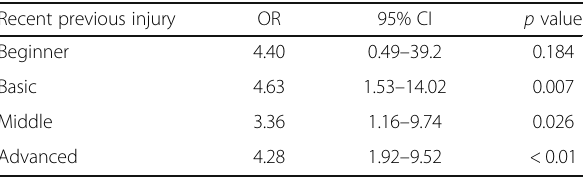
Table 3 Univariate binomial regression analysis between new injury and recent previous injury, by SeRUN® profile Recent previous injury OR 95% CI p